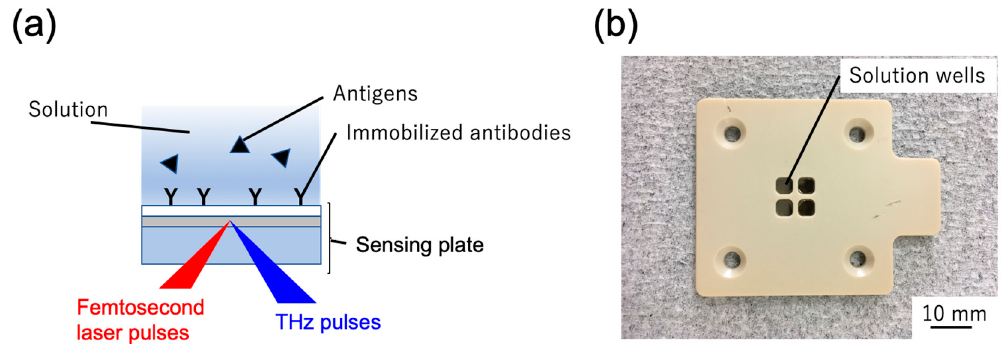
Figure 8. ( a ) Cross-sectional schematic of the sensing plate with antibodies on the surface of the sensing plate and ( b ) photograph of the solution wells filled with the antigens. Four wells were fabricated on the sensing plate.